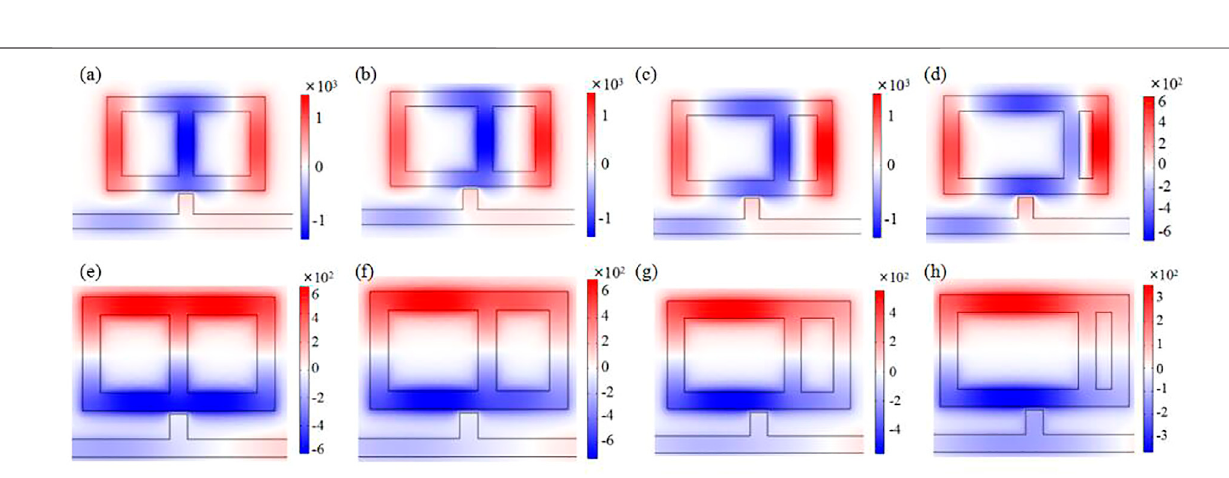
Frontiers in Physics |